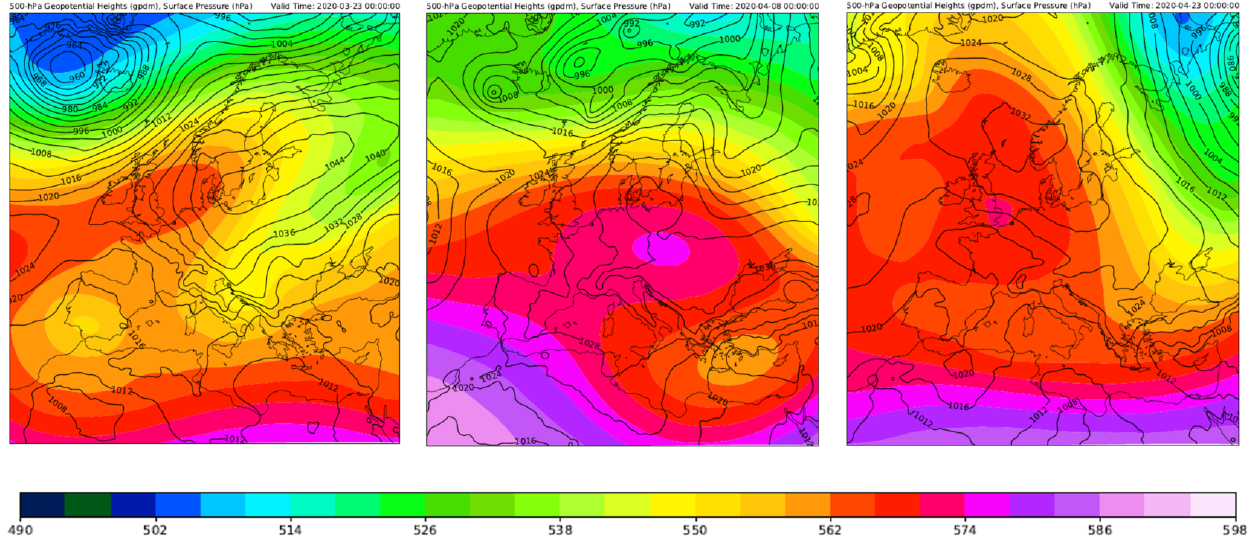
Figure 6. 500hPa geopotential heights (in geopotential decametres, gpdm) and surface pressure (in hPa) for selected time segments in March and April 2020 according to the COSMO simulations. The geopotential heights are averaged over 4d (21–24 March, 6–9 April and 21–24 April from left to right, respectively). Displayed surface pressure distributions are representative snapshots within those time segments.